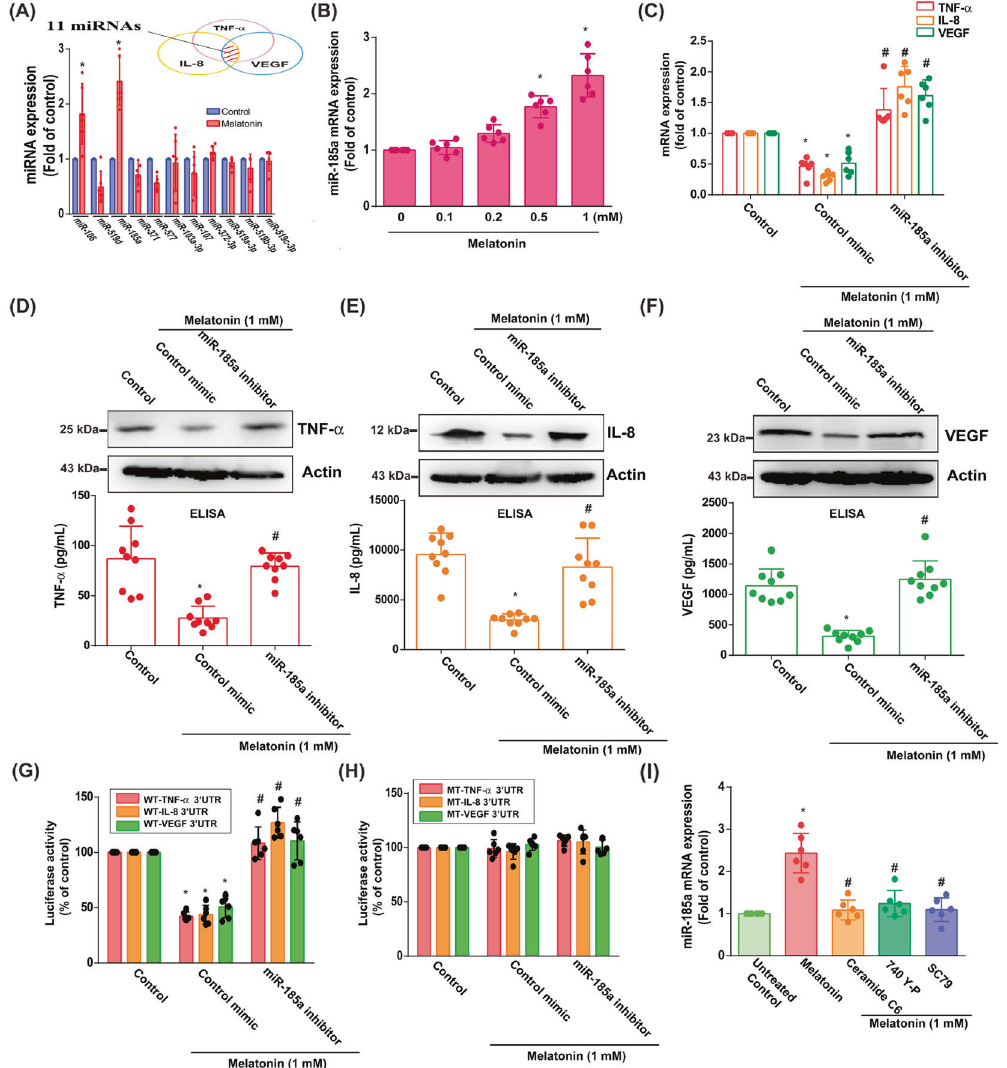
Fig. 4 Melatonin upregulated miR-185a expression and attenuated proin fl ammatory factor production. A Using 4 open-source software databases, we predicted that 11 miRs could bind the 3 ’ -UTRs of TNF- α , IL-8, and VEGF. After treating OASFs with melatonin (1 mM) for 24 h, miR levels were measured ( n = 6). B OASFs were treated with different concentrations of melatonin for 24 h, then analyzed by qPCR for miR- 185a expression ( n = 6). C – F OASFs were transfected with the miR-185a inhibitor for 24 h then incubated with 1 mM of melatonin. qPCR ( n = 6), western blot ( n = 3) and ELISA ( n = 9) assays determined TNF- α , IL-8, and VEGF levels, respectively. G , H OASFs were transfected with the indicated WT ( G ) or MT ( H ) luciferase plasmids, with or without the miR-185a inhibitor, then stimulated with melatonin (1 mM). Relative luciferase activity ( n = 6) was determined. I OASFs were treated with activators (740-YP, SC-79, or ceramide C6) for 30 min then incubated with 1 mM of melatonin. The qPCR assay ( n = 6) quanti fi ed miR-185a expression. Error bars indicate means ± S.D. * p < 0.05 versus controls; # p < 0.05 versus the melatonin-treated